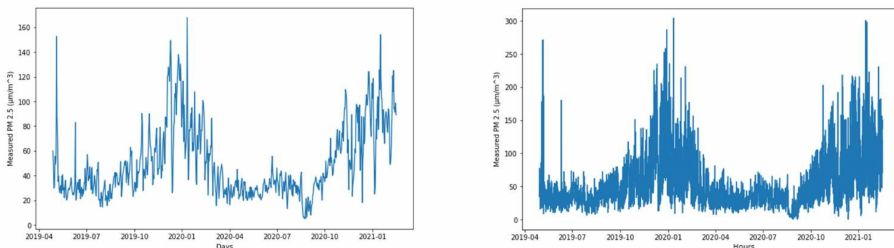
Figure 2. Islamabad daily and hourly PM 2.5 concentrations between 2019–2021.